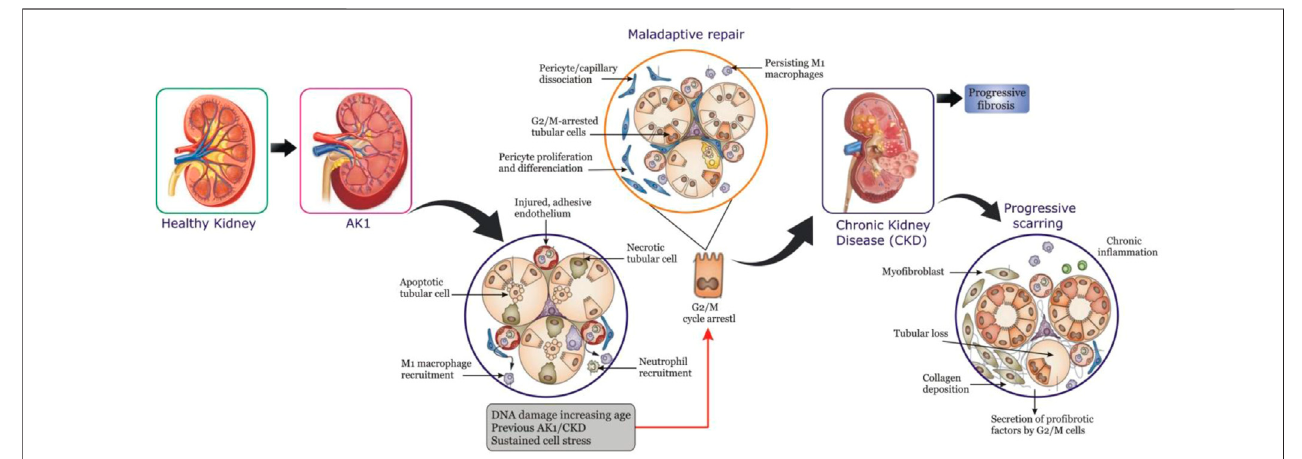
FIGURE 1 | Maladaptive repair after acute kidney injury (AKI) can result in chronic kidney disease (CKD).